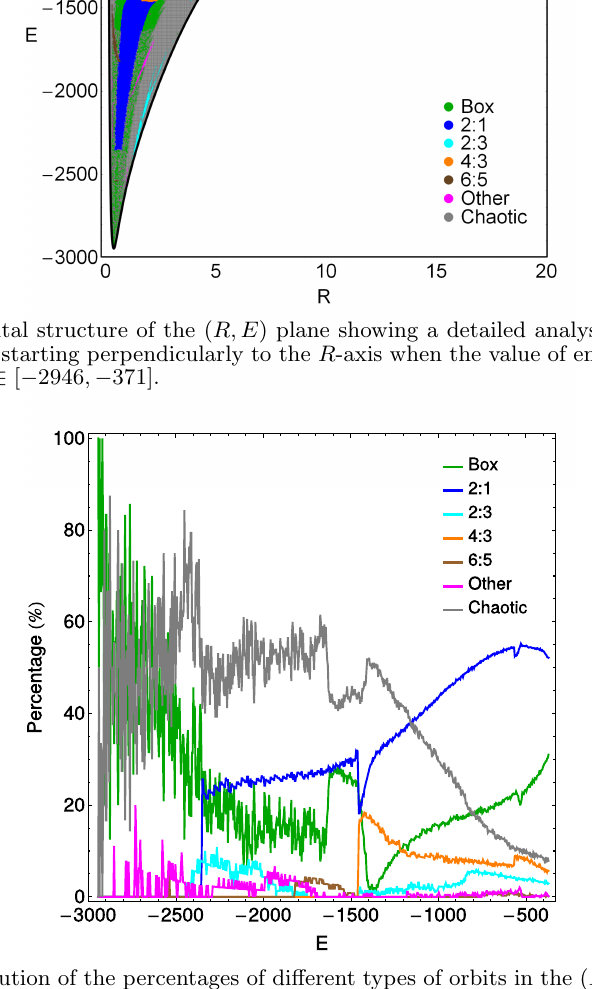
Fig. 5. Evolution of the percentages of different types of orbits in the ( R; E ) plane of our galaxy model as a function of the total orbital energy E . the horizontal R axis, parallel to the vertical z axis and in the positive